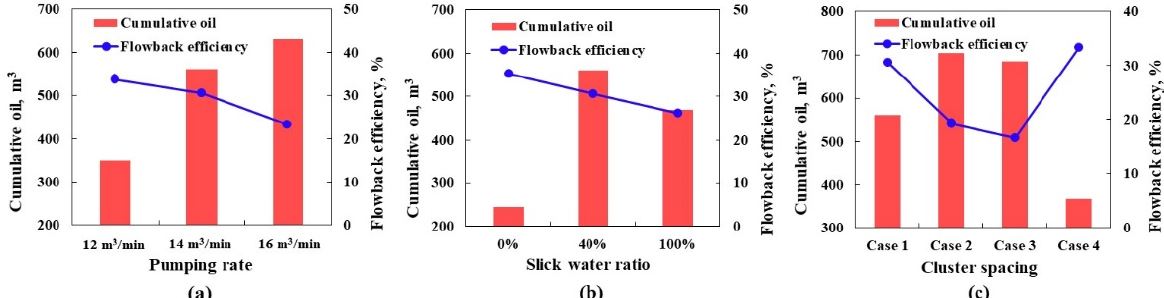
Figure 6. Cumulative oil and flowback efficiency: ( a ) pumping rate. ( b ) slick water ratio. ( c ) cluster spacing.